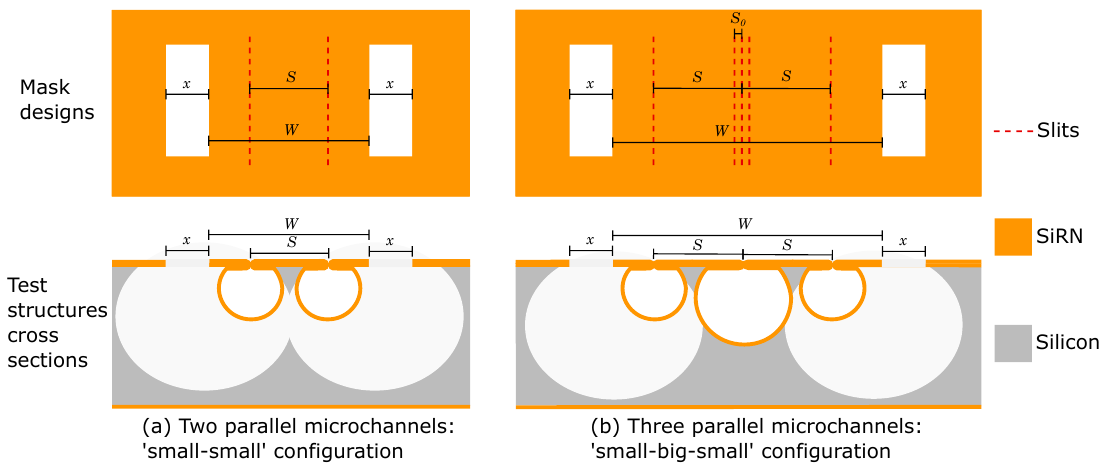
Figure 4. Mask designs and cross-sectional views of the test structures using ( a ) two small channels and ( b ) three channels with the small-big-small configuration. Design parameters S and W are varied in the test